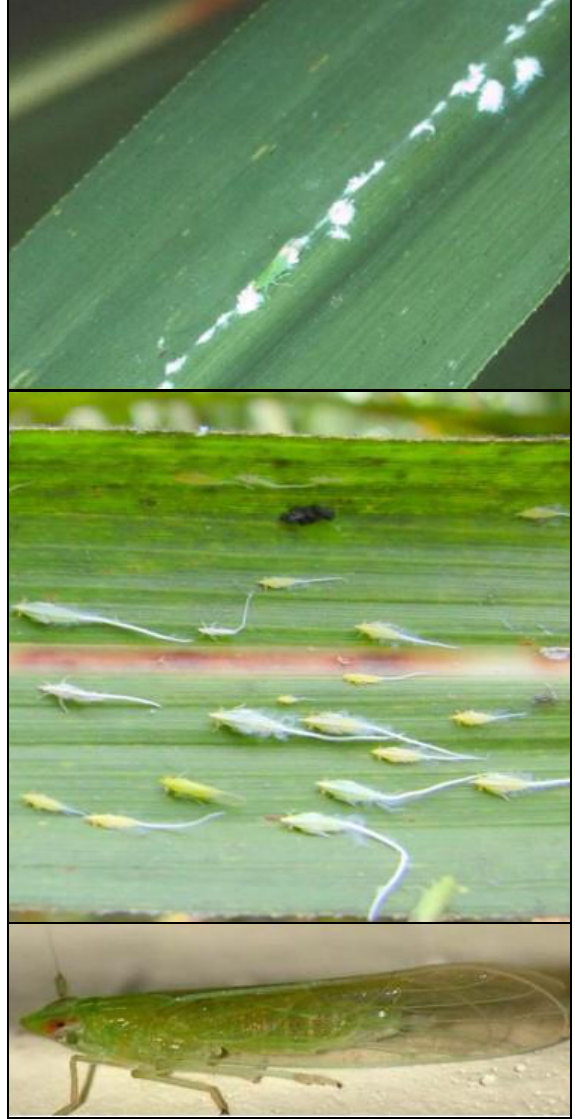
Figure 3. Saccharosydne saccharivora eggs (top), nymphs (middle), and adult (bottom). Photos: © B.E. Wilson.